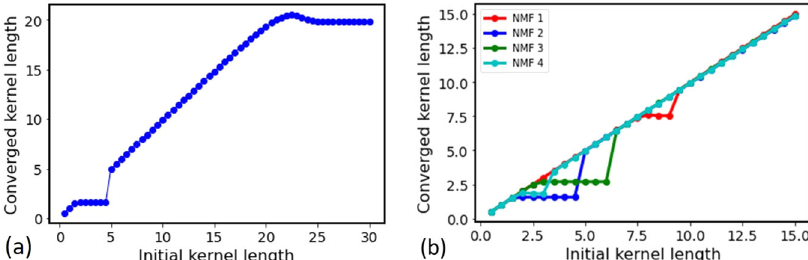
Fig. 3 Evolution of kernel length in the GP process as a function of limit of kernel length. Shown is a behavior for 2nd NMF component and b behavior for fi rst four NMF components. For all other NMF components the response yields a straight line.